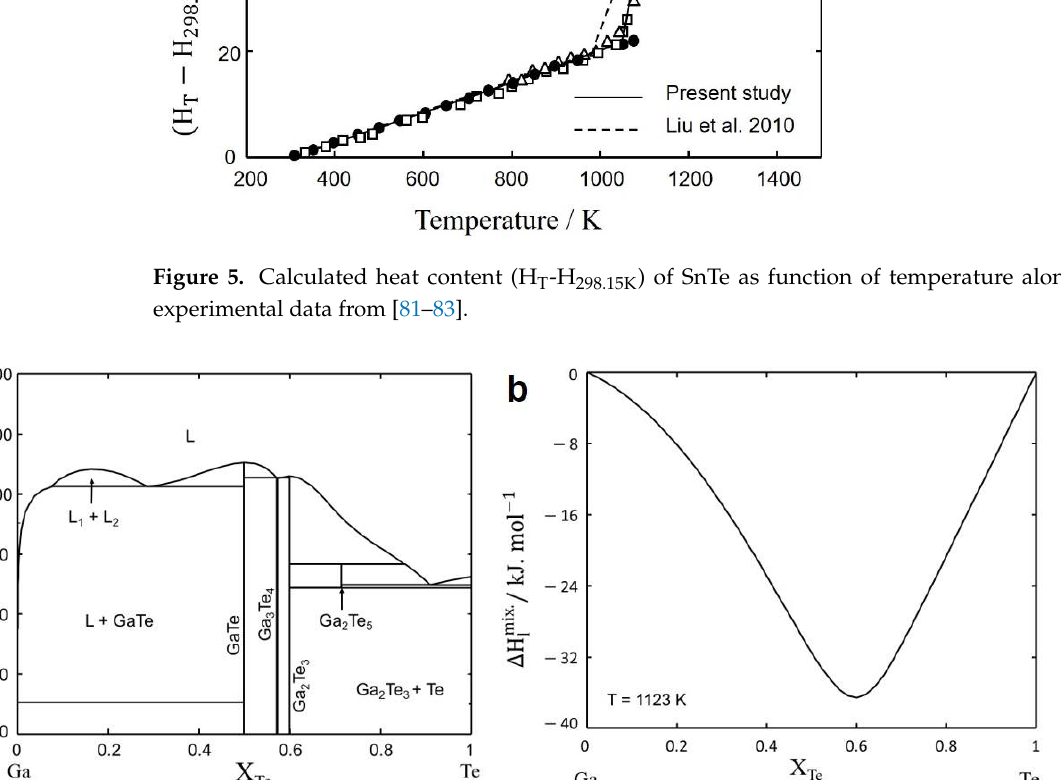
Figure 5. Calculated heat content (H T -H 298.15K ) of SnTe as function of temperature along with experimental data from [81–83].